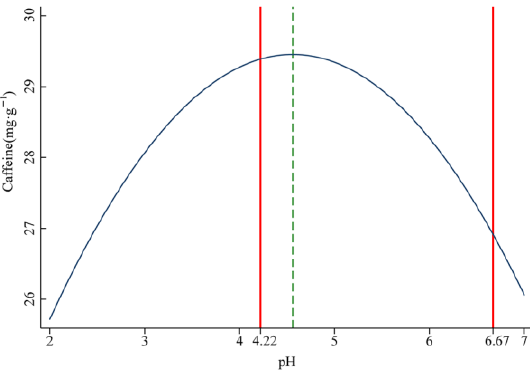
Figure 6. Quantitative relationship between the caffeine and soil pH.